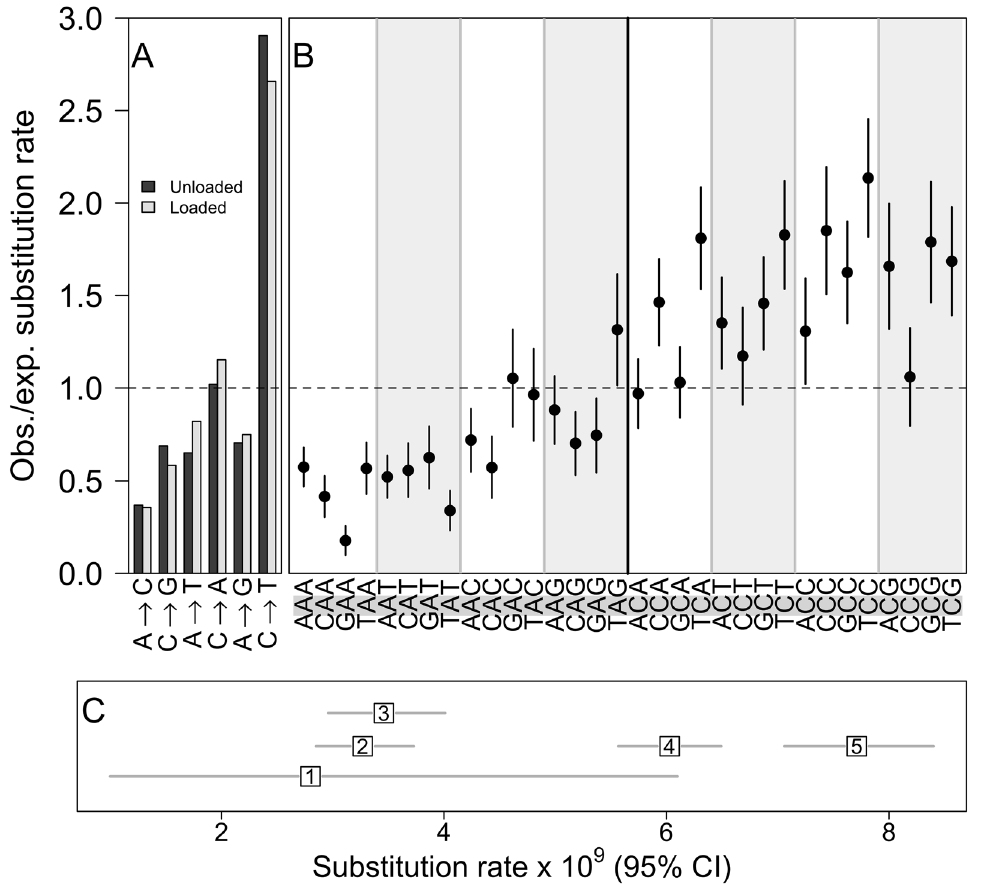
Fig 2. Spectrum and context dependence of single-nucleotide substitutions. (A, B) Observed substitution rates relative to the rate expected if all substitutions were equally likely. (A) The six possible substitutions occurred at unequal rates ( χ 2 = 434, df = 5, p < 1 × 10 − 15 ), with no difference between loaded and unloaded backgrounds ( χ 2 = 2.87, df = 11, p = 0.99). (B) Rates of substitution at the central nucleotide (highlighted in grey) for each 3-bp context, with standard error bars. Substitution rate was higher for G:C sites (paired t = 9.69, df = 15, p < 1 × 10 − 7 ) and varied significantly with 3-bp context at both A:T sites ( χ 2 = 39.24, df = 15, p < 0.001) and G:C sites ( χ 2 = 25.24, df = 15, p = 0.047), but neither differed between loaded and unloaded backgrounds ( χ 2 = 10.56, df = 63, p = 1; values shown are pooled across backgrounds). (C) Comparison of substitution rate estimates among recent studies. Our estimate ( “ 4 ” ) is intermediate compared with the two backgrounds studied by [19] ( “ 2 ” and “ 5 ” ); “ 1 ” = [20], “ 3 ” = [21]. See S1 Data for plot data.